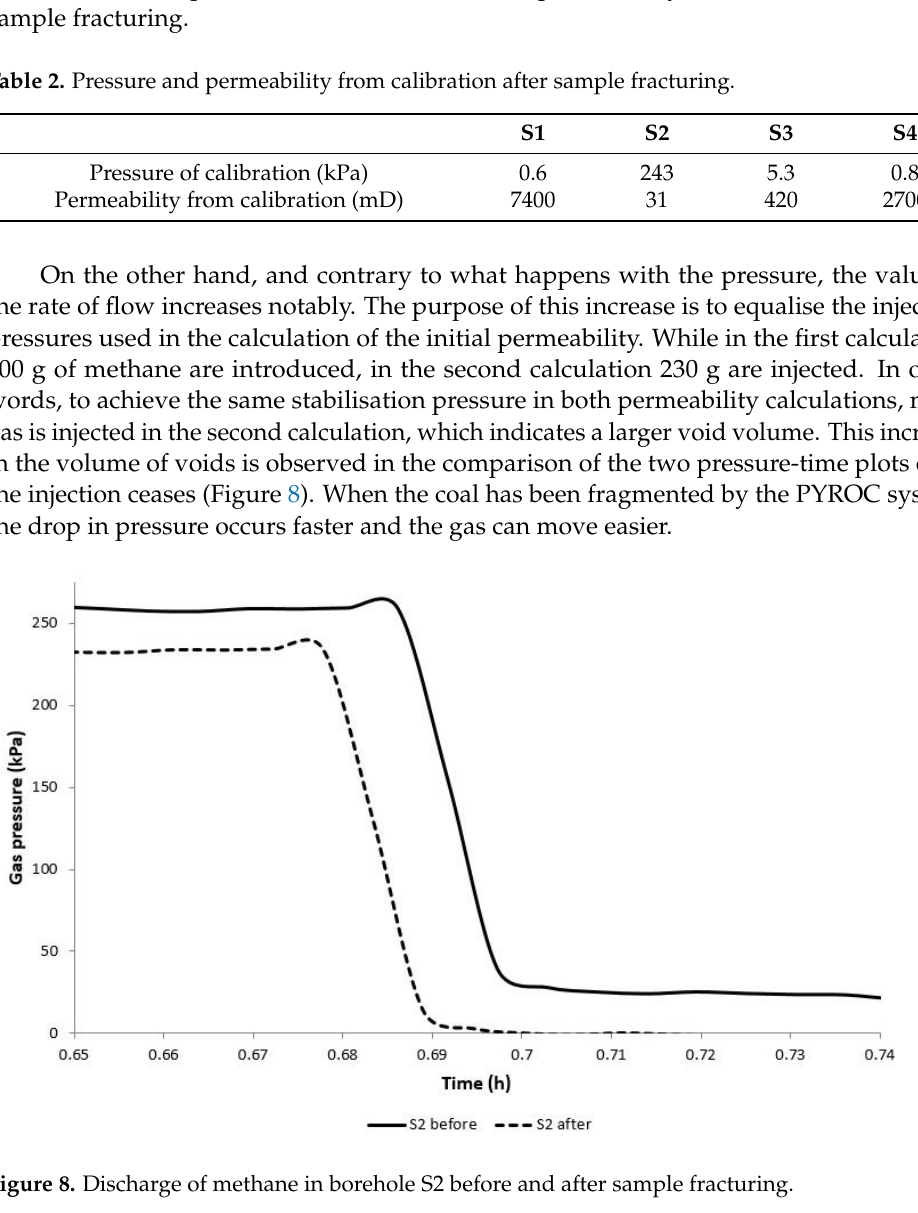
Figure 8. Discharge of methane in borehole S2 before and after sample